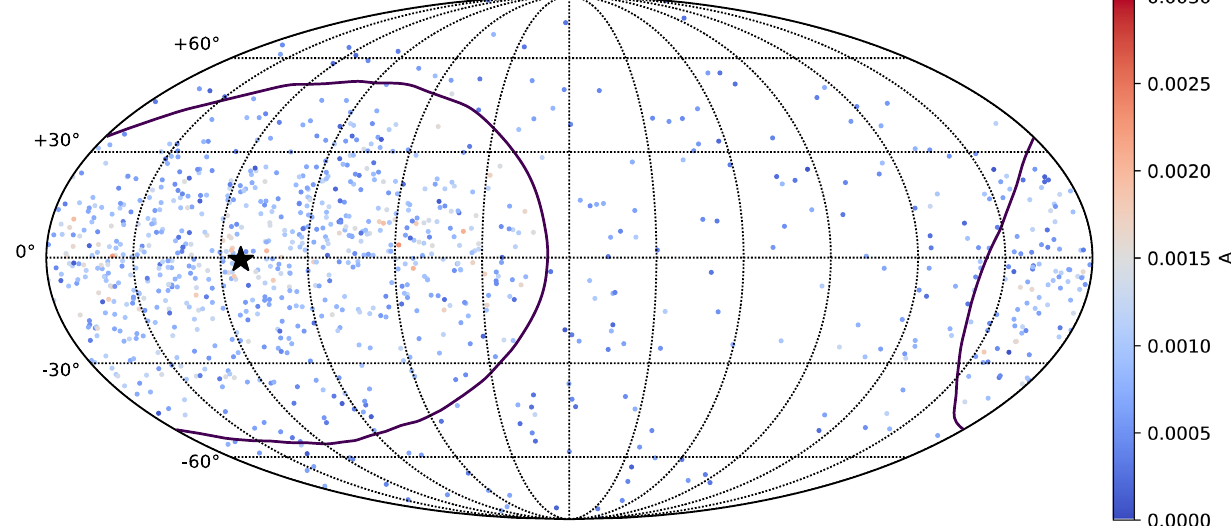
Fig. 3 Similar to Fig. 2 for the Constitution data